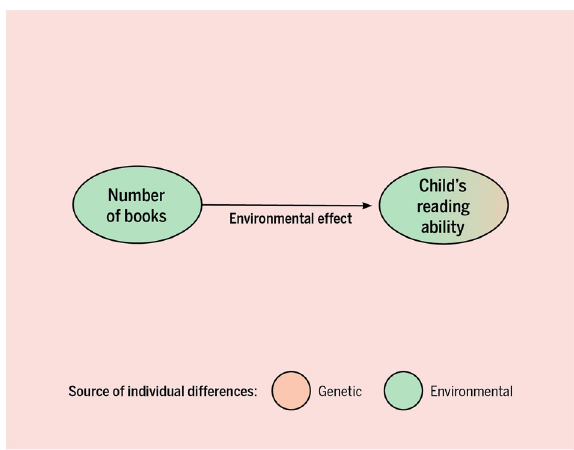
Fig. 1 An example of a direct environmental transmission effect. Number of books in the home is thought to be an environmental causal effect on children ’ s reading ability. Figure by ref. 66 available at https://bit.ly/3gl8MVk under a CC BY 4.0 license.